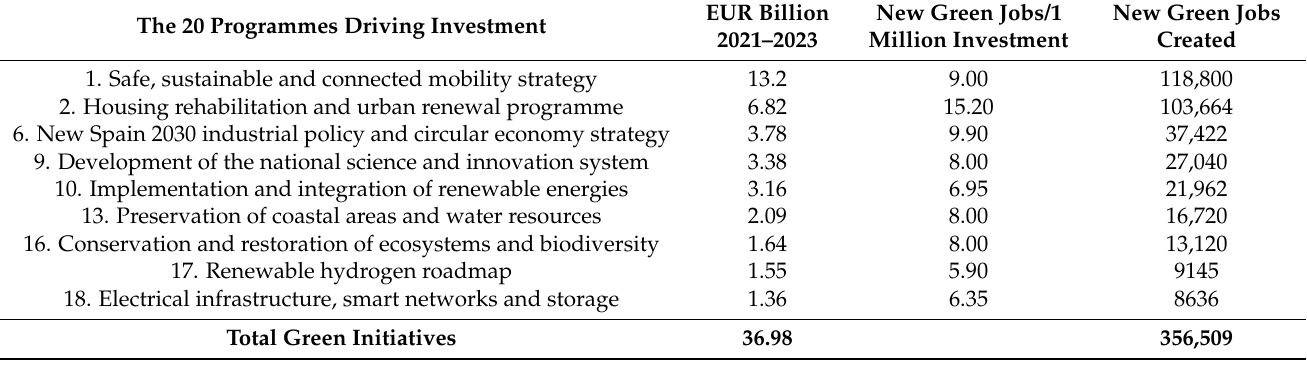
Table 5. Green jobs created and green initiatives. Source: own elaboration with data from IEA [55] and the Spanish Recovery Plan [16].